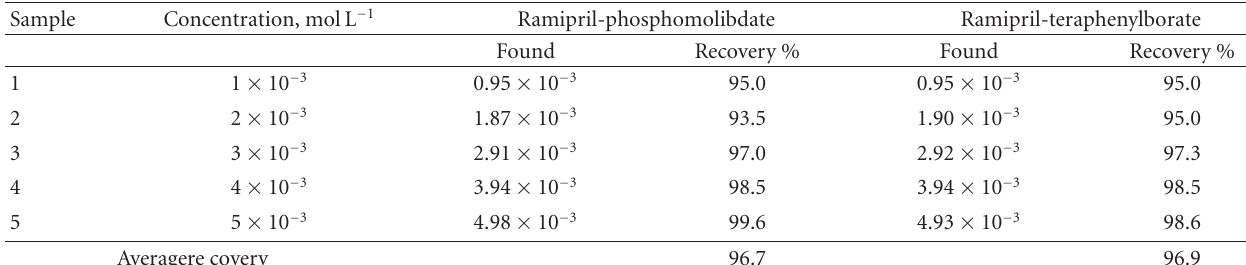
Table 3: The accuracy and reliability of result obtained with ramipril PVC matrix membrane electrode.